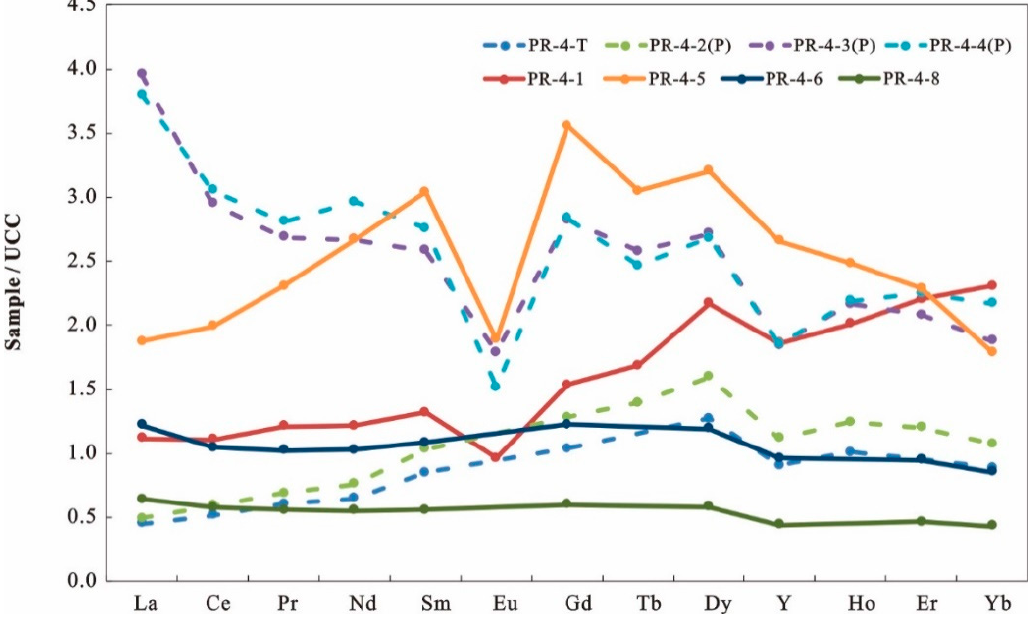
Figure 12. The Upper Continental Crust (UCC)-normalized rare earth elements and yttrium (REY) distribution patterns in the Permian coals. (UCC data are from Taylor and McLennan [56]).